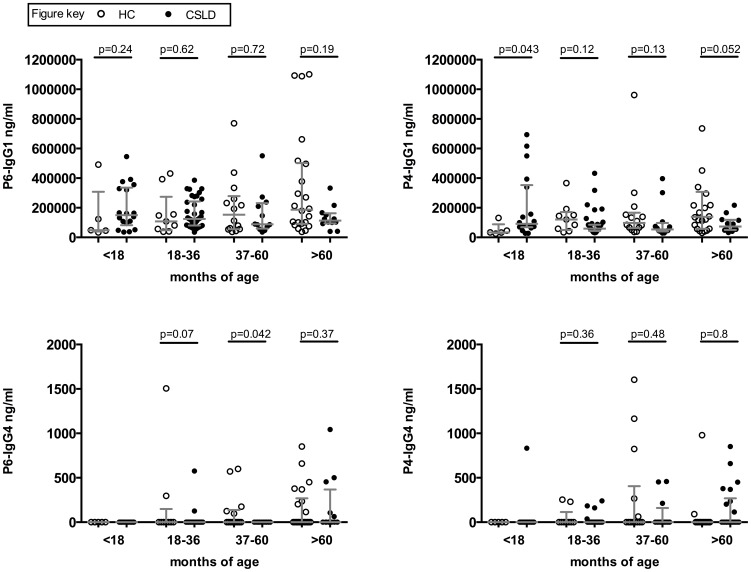
Serum IgG1 and IgG4 to outer membrane proteins P4 and P6.HC (open circles) and CSLD (filled circles). Concentration with median and inter-quartile range.